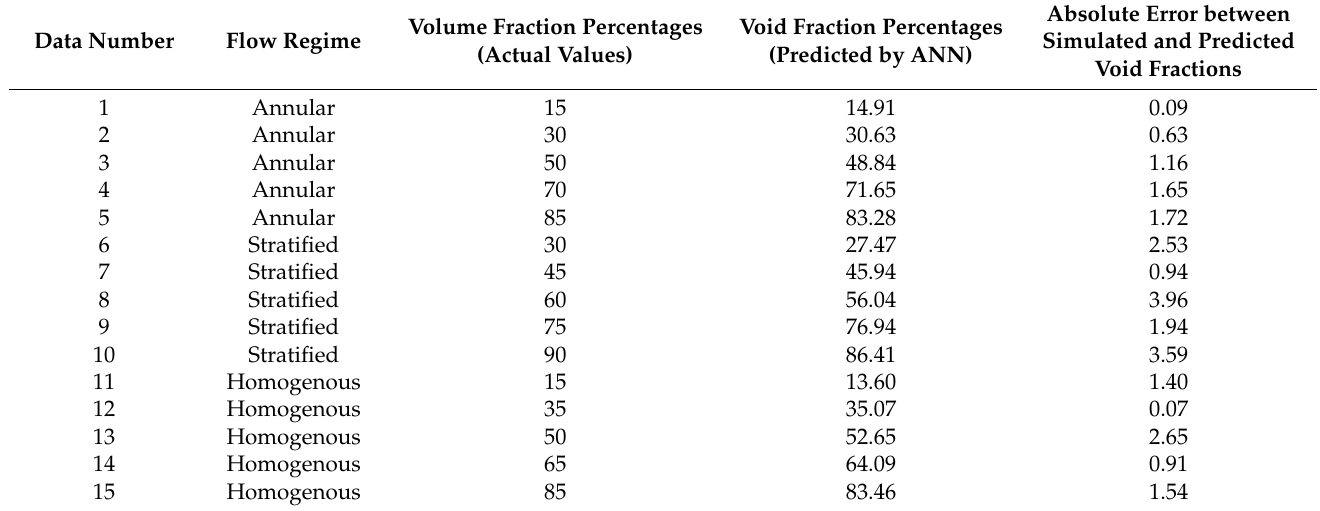
Table 6. The actual and predicted values of volumetric percentages (testing